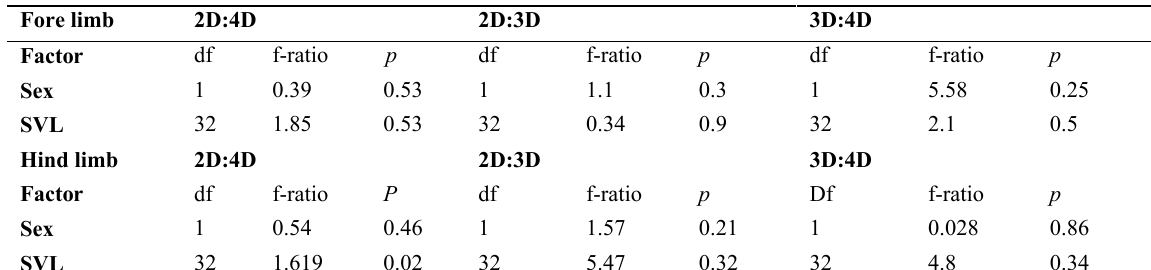
* F-tests refer to the Levene’s test for the equality of variances, whereas the t-tests refer to sex differences. Effect sizes (Cohen’s d) are calculated for each of these two tests (dvar and dmean, respectively). Table 2. The effect of sex, snout-vent length (SVL), on the digit ratios 2D: 4D, 3D: 4D and 2D: 3D of the fore and hind limb in D.